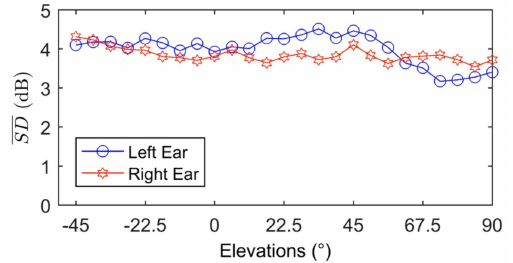
Figure 3. Mean spectral distortion across 25 elevations in the median plane when using 10-order independent component analysis (ICA) reconstructive HRTFs. Values are averaged among 30 subjects in the illustrative